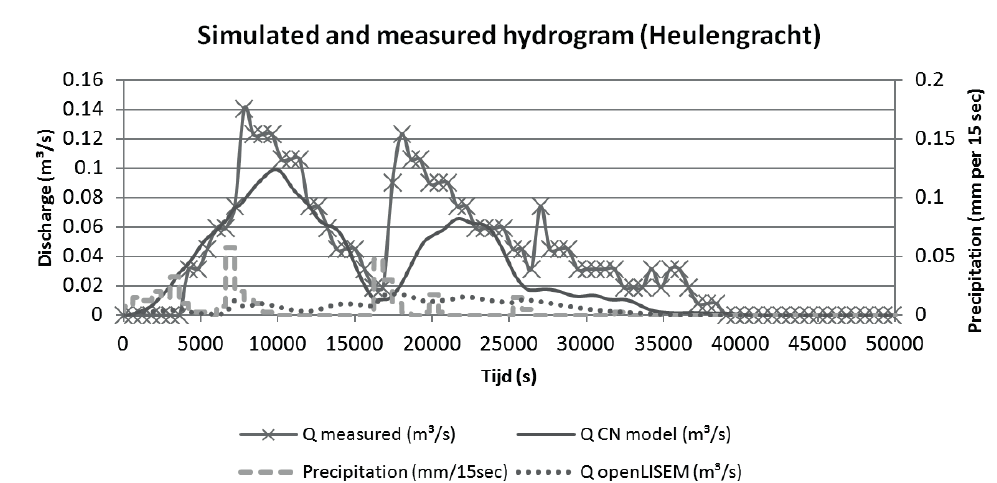
Fig. 1 Simulated (openLISEM and the modified CN model) and measured hydrographs for the event of 29/05/2006 at the Heulengracht